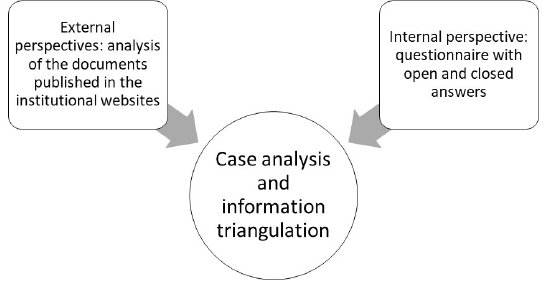
Figure 1. Flowchart of the analysis process.